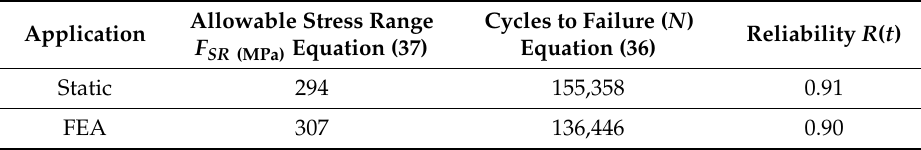
Table 7. Summary fatigue life welded joint S ‐ N results.